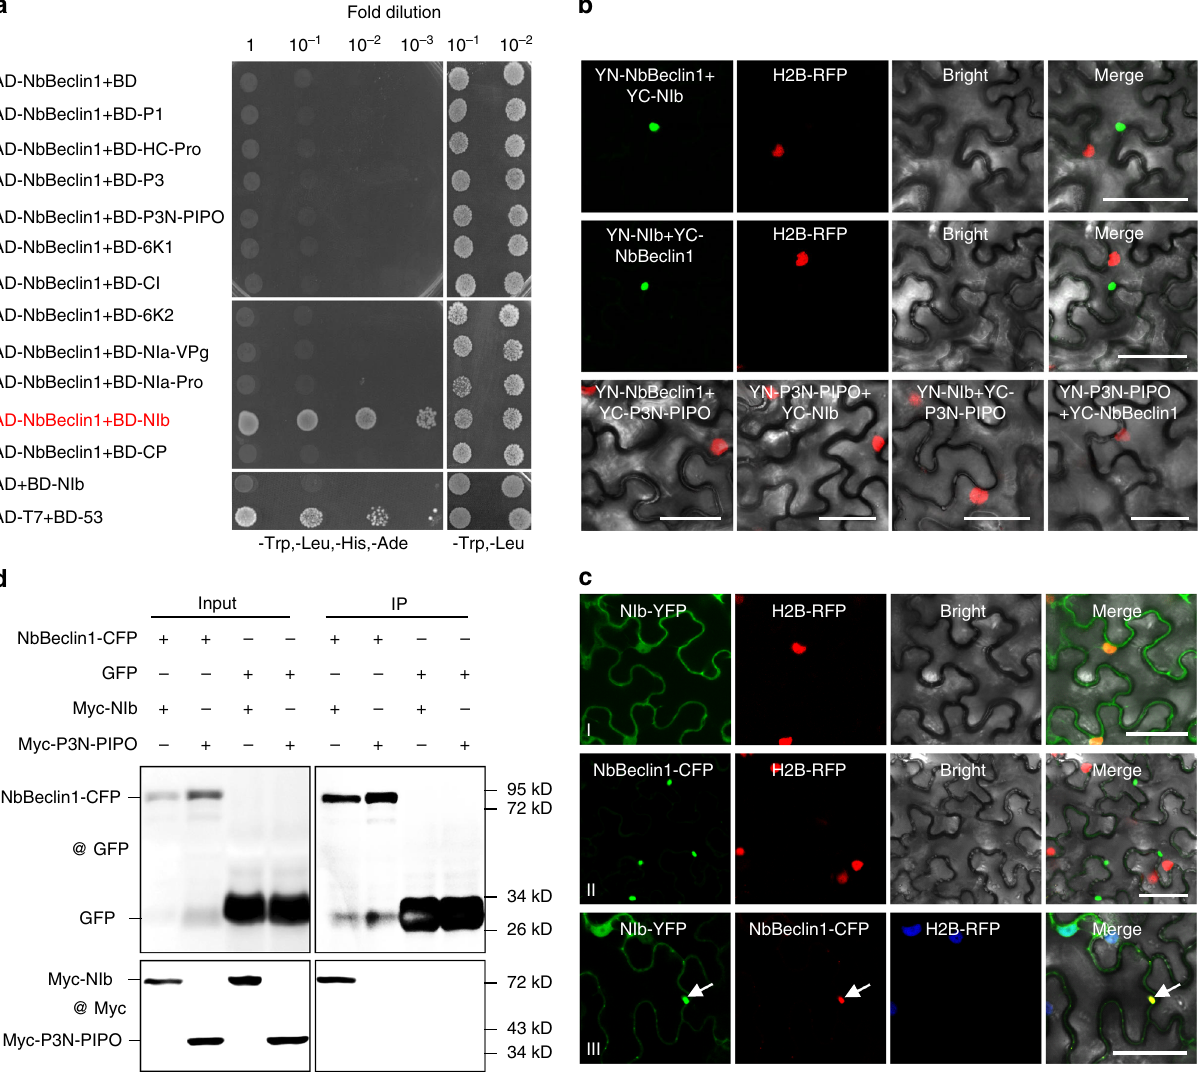
Fig. 2 NbBeclin1 interacts with NIb. a Yeast-two hybrid (Y2H) assays for possible interactions between NbBeclin1 and each of the 11 TuMV proteins. NbBeclin1 and 11 viral proteins were fused with a GAL4 activation domain (AD-NbBeclin1) and a GAL4-binding domain (BD-P1, BD-HC-Pro, BD-P3, BD-P3N-PIPO, BD-6K1, BD-CI, BD-6K2, BD-NIa-VPg, BD-NIa-Pro, BD-NIb, BD-CP), respectively. Y2H Gold yeast cells co-transformed with the indicated plasmids were subjected to 10-fold serial dilutions and plated on synthetic dextrose (SD)/-Trp, -Leu, -His, -Ade or SD/-Trp, -Leu medium to screen for positive interactions at 3 days after transformation. Yeast co-transformed with AD-T7-T + BD-T7-53 serves as a positive control; yeast cells co-transformed with AD-NbBeclin1 and the empty BD or with the empty AD and BD-NIb are negative controls. b BiFC assays between NbBeclin1 and NIb in the leaves of H2B-RFP transgenic N . benthamiana . Confocal imaging was performed at 48 hpi. NbBeclin1 and NIb were fused to the N (YN) and C-terminal (YC) fragments of yellow fl uorescent protein (YFP). The NbBeclin1-NIb interaction led to the reconstituted fl uorescence-competent structure and restoration of yellow fl uorescence (green). Nuclei of tobacco leaf epidermal cells are indicated by the expression of H2B-RFP transgene (red). Bars, 50 μ m. c Co- localization of NIb-YFP with NbBeclin1-CFP in the leaf cells of H2B-RFP transgenic N . benthamiana by confocal microscopy at 48 hpi. Arrow indicates yellow fl uorescence, which was produced from the overlapping of NIb-YFP (green) and NbBeclin1-CFP (red). Bars, 50 μ m. d Co-immunoprecipitation (Co-IP) analysis of NbBeclin1-CFP and Myc-NIb in vivo. N . benthamiana leaves were co-in fi ltrated with A . tumefaciens cells harboring expression vectors to express